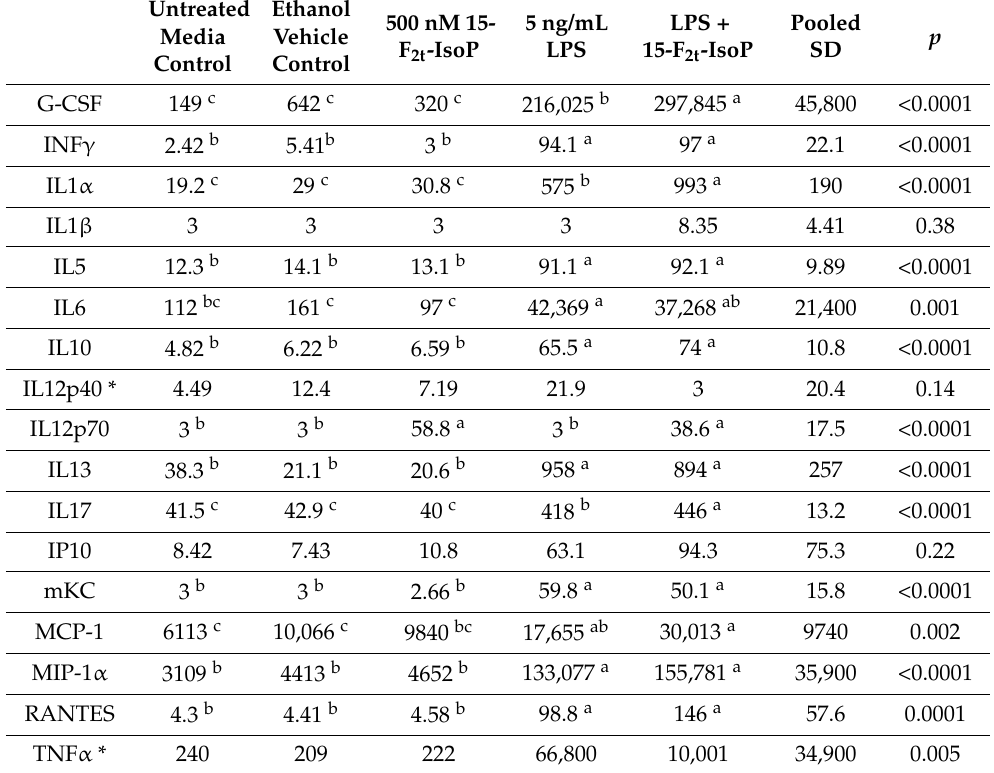
Table 1. Mean concentrations (pg/mL) of cytokines produced by RAW 264.7 cells ( n = 7) treated with endotoxin and 15-F 2t -isoprostane. Statistical analyses included a one-way ANOVA with Tukey’s HSD posthoc test unless indicated otherwise. Bonferroni’s correction was used to account for family-wise error ( p < 0.002). a–c Means within a row with different superscripts are different ( p < 0.05). LPS— lipopolysaccharide; G-CSF—granulocyte colony-stimulating factor; INF—interferon;